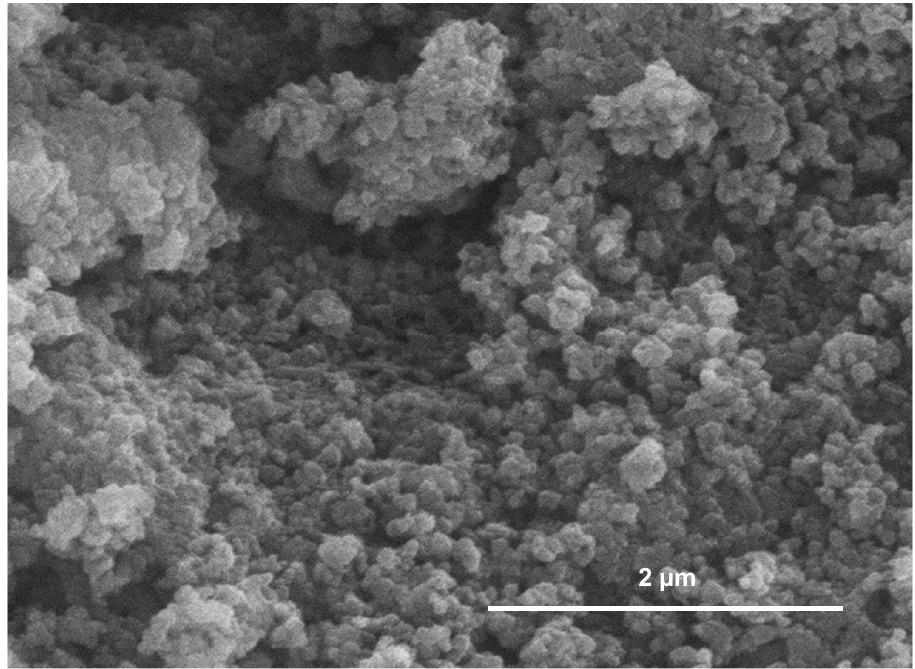
Figure 5. SEM image of untreated CuHCF powder.